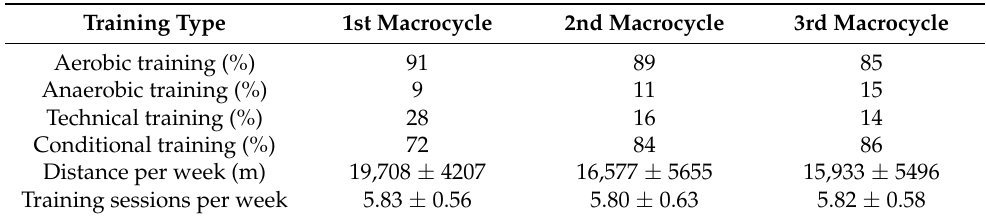
Table 2. Swimming training content, volume, and frequency per macrocycle along a young swim- mer’s training